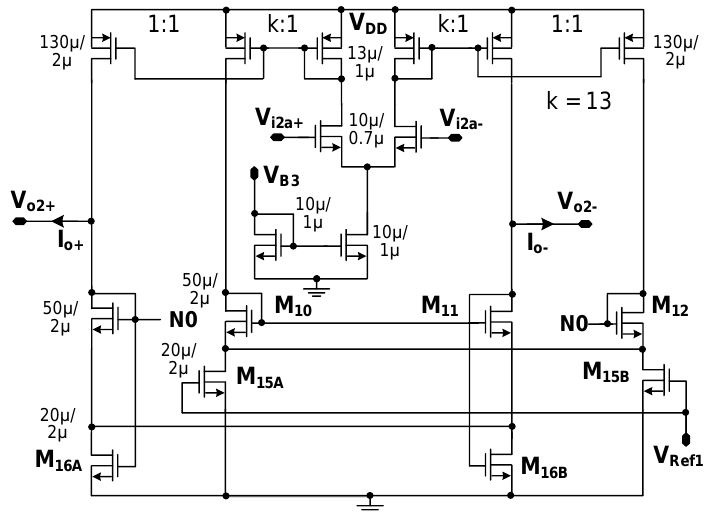
Figure 6. Schematic of the transconductor.